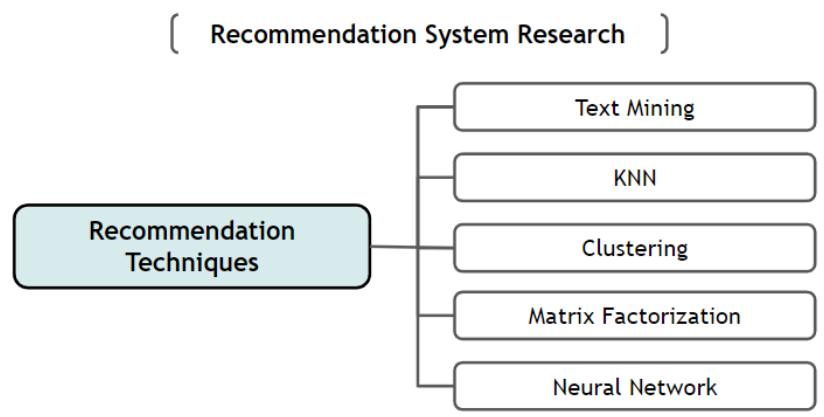
Figure 11. Technology mainly used in recommendation system.